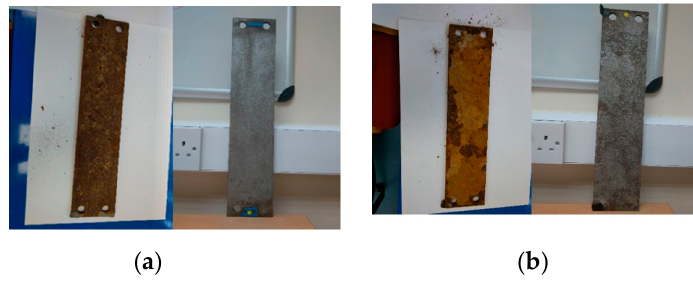
Figure 7. Samples: ( a ) before cleaning, ( b ) after cleaning.